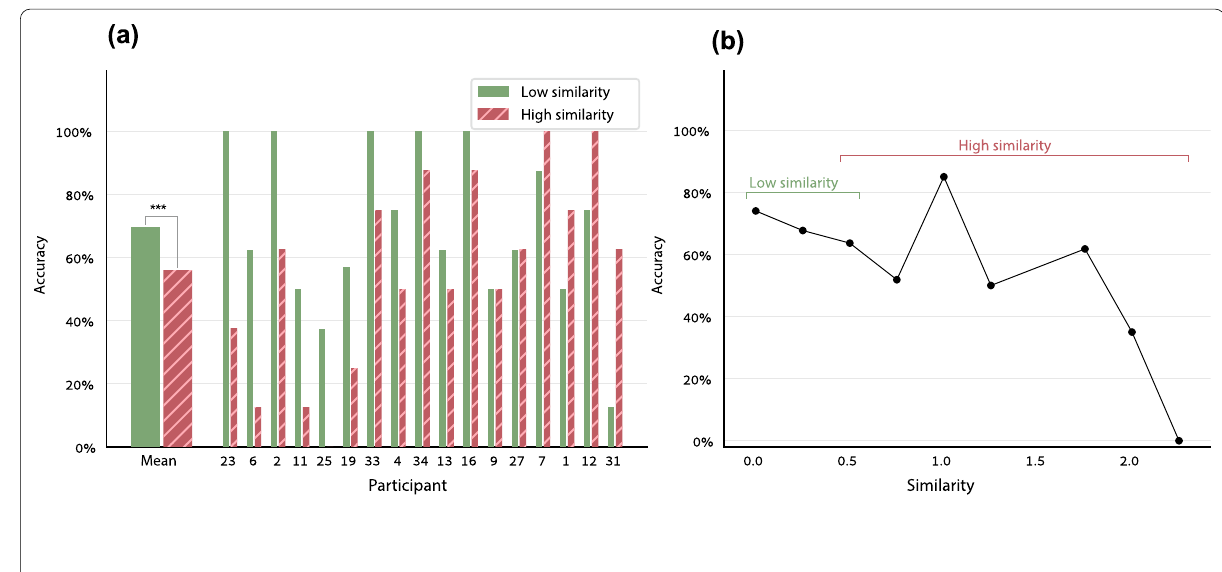
Fig. 2 Results of the end‑of‑week tests—better learning of dissimilar facts than similar ones. a The children were more accurate in the low‑similarity weeks than in the high‑similarity weeks. The thinner bars show the individual results of each participant. b Accuracy decreased as a function of the fact’s average similarity to the 3 other facts learned in the same week, even within the low‑similarity sets and the high‑similarity sets, suggesting that the fact‑specific similarity is